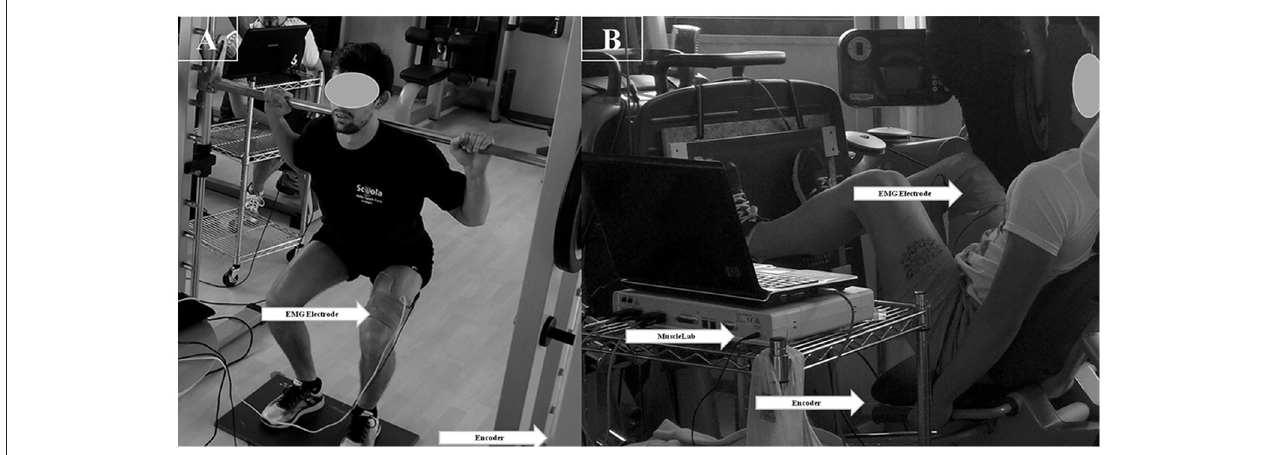
FIGURE 1 | Participant exercising at Multipower (A) and at Leg press (B) . EMG electromyography activity. Written informed consent for the publication of image was obtained from participant.